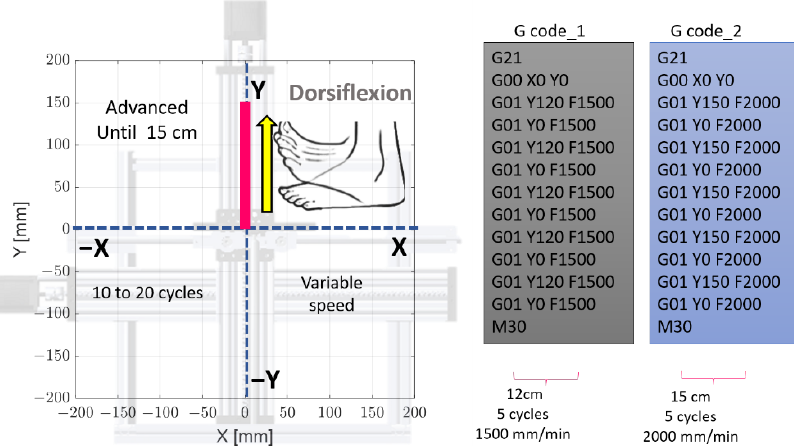
Figure 18. Advanced level for dorsiflexion rehabilitation.